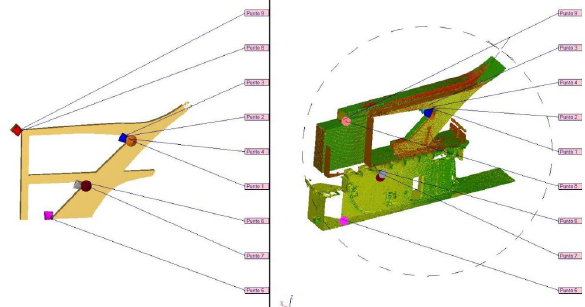
Figure 4 . Registration between the 3D model (achieved from the original Nervi’s design drawings) and the LiDAR point cloud.